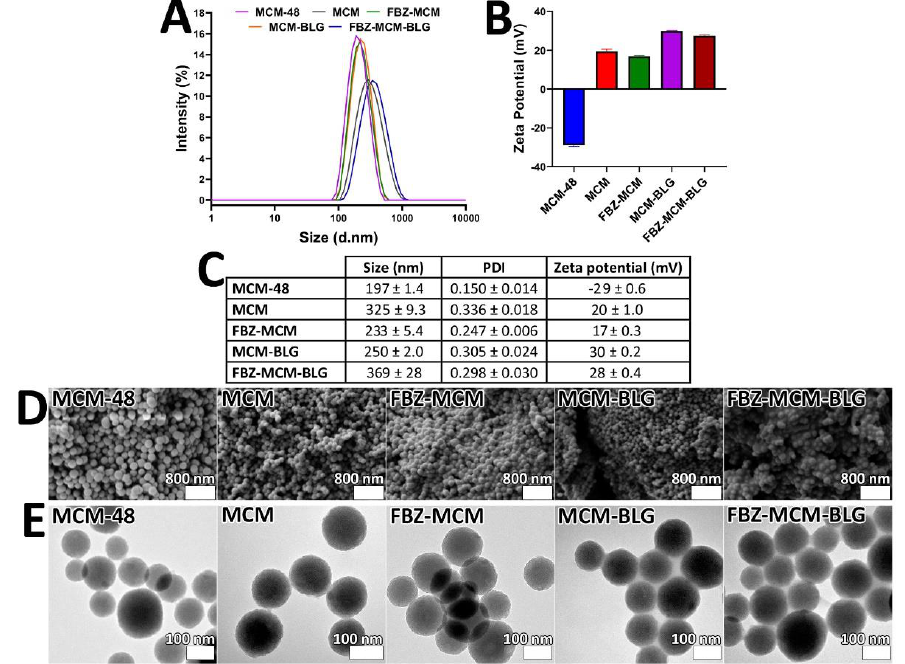
Figure 1. ( A ) Size diagrams of MCM-48, MCM, FBZ-MCM, MCM-BLG, and FBZ-MCM-BLG nano- particles. ( B ) Zeta potential of MCM-48, MCM, FBZ-MCM, MCM-BLG, and FBZ-MCM-BLG nanopar- ticles. ( C ) Size, polydispersity index (PDI), and zeta potential of the formulations. ( D ) Scanning